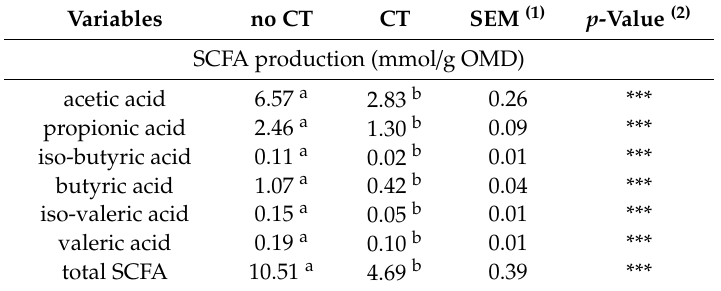
Table 3. E ff ect of tannins on short-chain fatty acids (SCFA) production, evaluated during in vitro organic matter rumen fermentation with and without condensed tannins (CT).